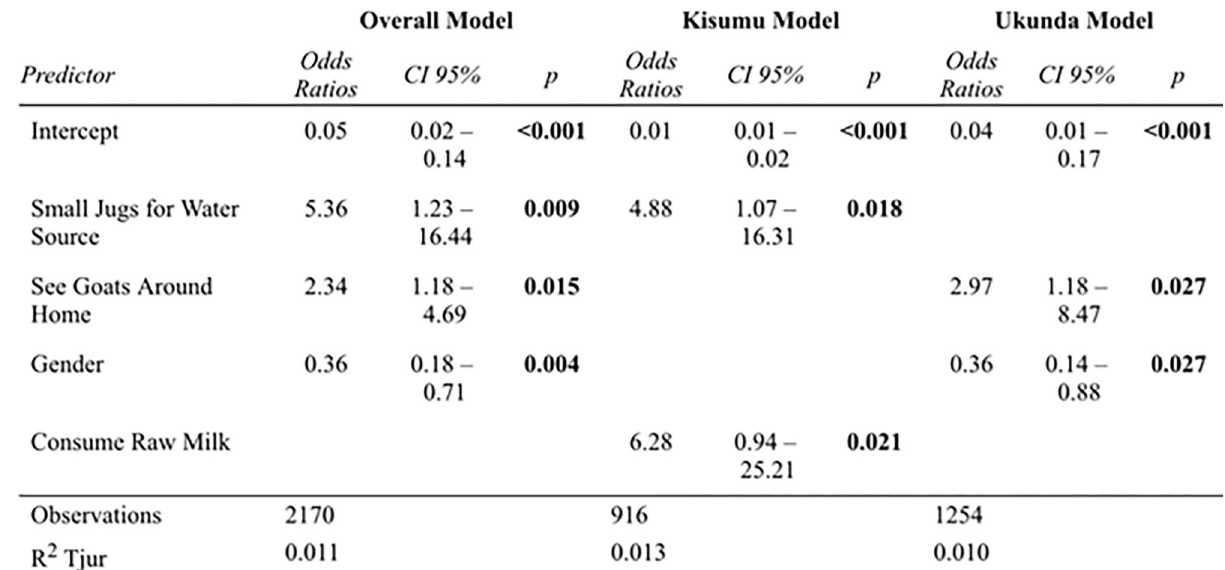
Fig 5. Multivariate models to predict RVFV seropositivity overall and by each